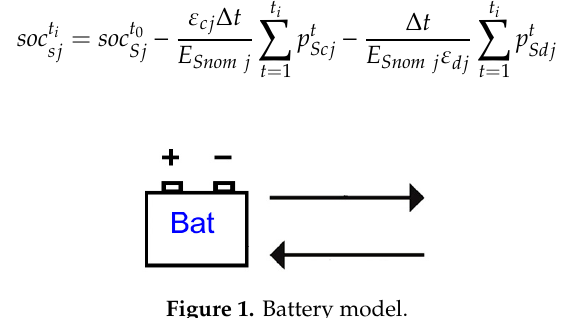
Figure 1. Battery Figure 1. Battery model.